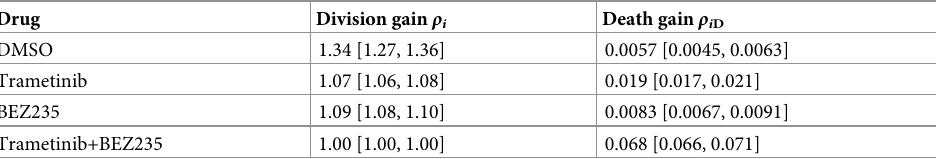
Table 1. Drug-specific division gains and death